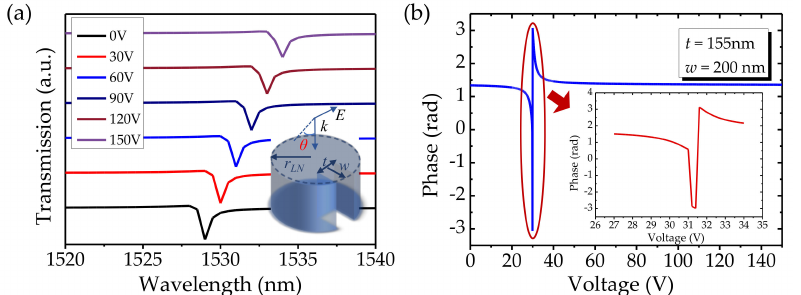
Figure 5. ( a ) The transmission spectra of the asymmetric cylinder for different voltages. The voltage increases from 0 to 150 V in steps of 30 V. The asymmetric cylinder: h = 400 nm, r = 333 nm, t = 155 nm, w = 200 nm, θ = 0 ◦ . ( b ) The transmission phase function of applied bias voltage at the operating wavelength of 1528.9 nm, θ = 0 ◦